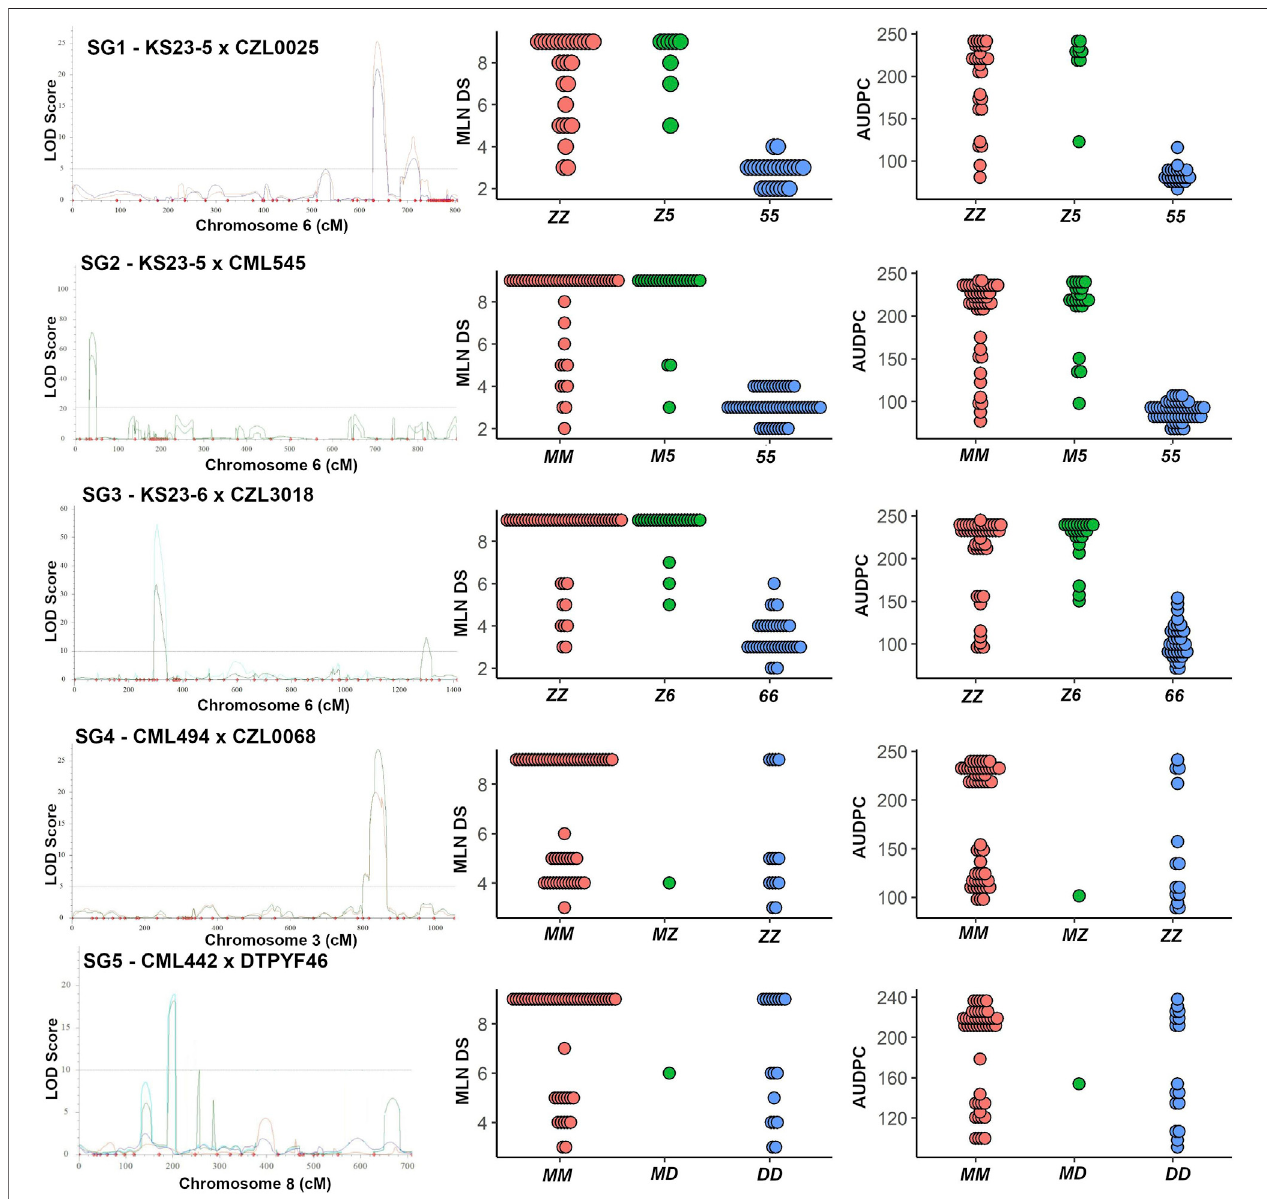
FIGURE 3 | Genomic regions in fl uencing MLN resistance in three KS23 derived populations and non-KS23 – based populations. A logarithm of odds (LOD) scan showing the major QTL identi fi ed on chromosome 6 (for fi rst three KS23-based populations) and a dot plot for the closest marker for MLN_DS and AUDPC values are shown.Similarly,aLODscanshowingthemajorQTLidenti fi edonchromosome3and8(SG4andSG5)andadotplotfortheclosestmarkersareshown.InSG1,ZZand 55correspondtoallelesfromparentCZL0025andKS23-5,respectively.Similarly,inSG2,MMand55correspondtoallelesfromCML545andKS23-5;inSG3,ZZ and 66 correspond to CZL3018 and KS23-6; in SG4, MM and ZZ correspond to alleles from CML494 and CZL0068; and in SG5, MM and DD correspond to alleles contributed from CML442 and DTPYF46,